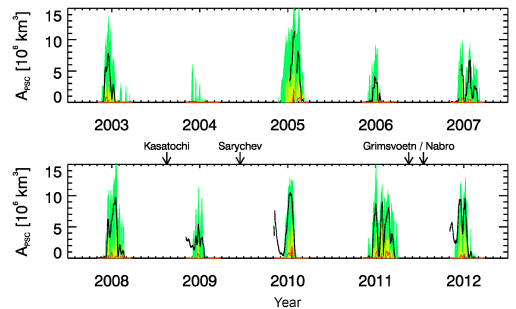
Figure 14. SH interseasonal variation in A PSCmax between 15 and 30km with the black line for MIPAS (7-day running mean), green and light green coloured areas retrieved from ERA-Interim daily temperature fields and fixed H 2 O / HNO 3 profile for high case and low case (see Sect. 4.2.3) and A ICEmax with a red line for MIPAS, blue and light blue bars for ERA-Interim high case and low case, respectively. In the Antarctic polar winter of 2004, MIPAS mea- surements are not available.